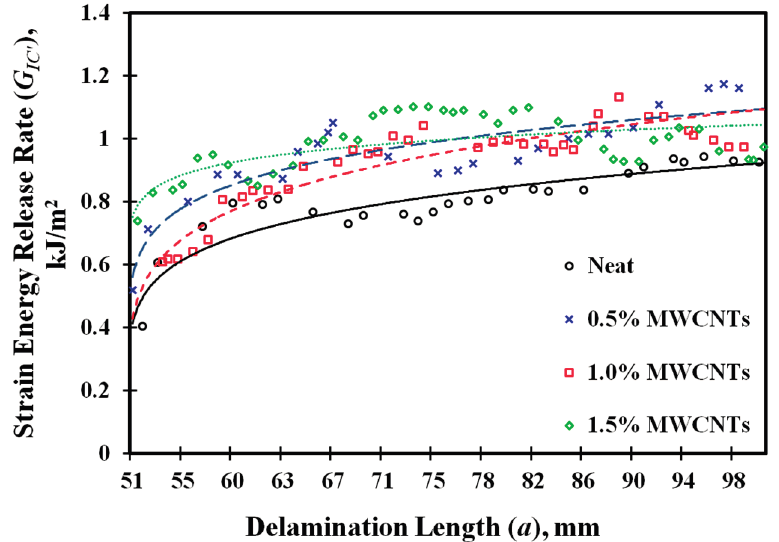
Figure 10. The resistance curves ( R -curves) for the MWCNT/epoxy unidirectional CFRP composites.